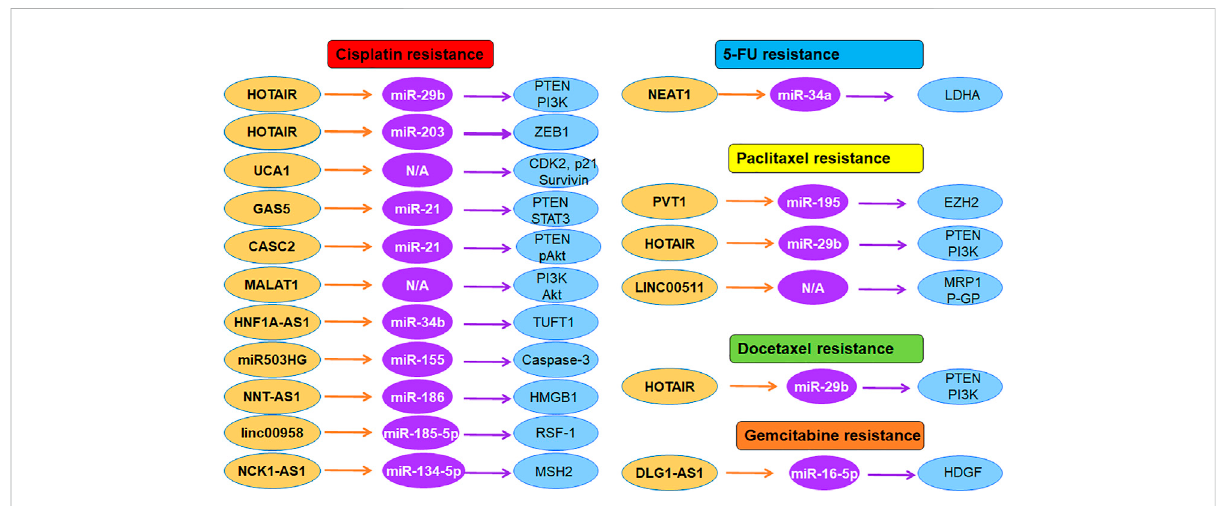
The role of lncRNAs in regulation of chemoresistance in cervical cancer. Multiple lncRNAs participate in cisplatin resistance, 5-FU resistance, paclitaxel resistance, and gemcitabine resistance in cervical